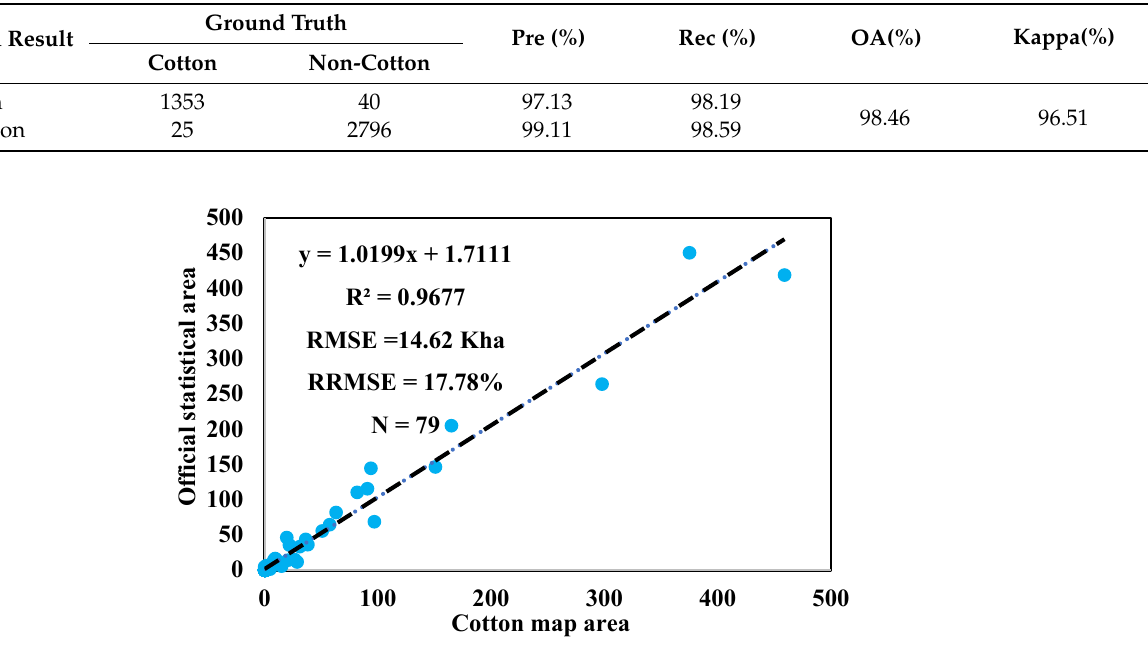
Figure 9. Comparison of cotton area in county-level municipalities between Sentinel-2 map and official statistics.